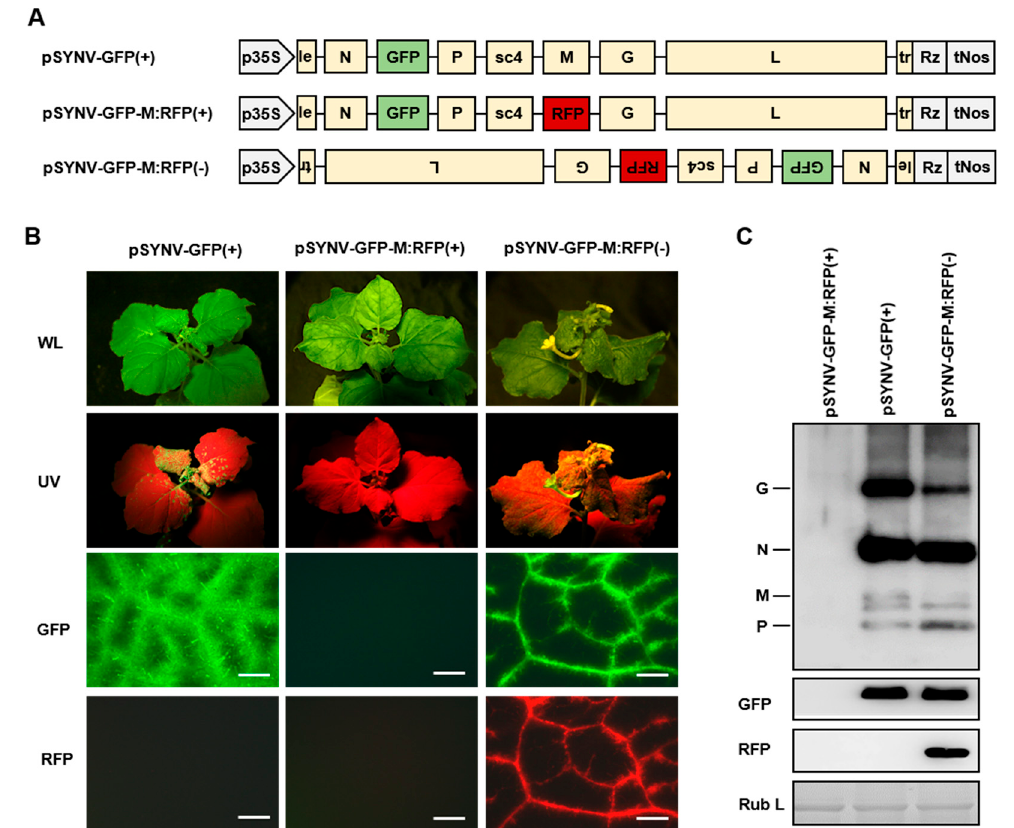
Figure 4. Recovery of recombinant SYNV M deletion mutant from a genomic but not antigenomic cDNA clone. ( A ) Schematic representation of the pSYNV ‐ GFP ‐ M:RFP(+) and pSYNV ‐ GFP ‐ M:RFP( ‐